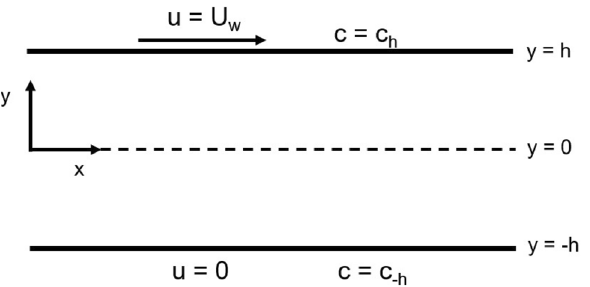
Figure 2. Shows physical configurations to knee joint in which synovial fluid is confined between two infinitely long parallel plates apart by a distance of 2 h with the top plate is moving with the help of BJ